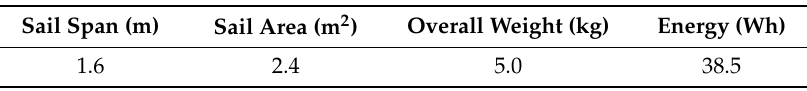
Figure 1. UAS ((unmanned aerial systems) sketch ( left ); atmosphere sensor dimensions ( right ). Table 1. UAS main features.